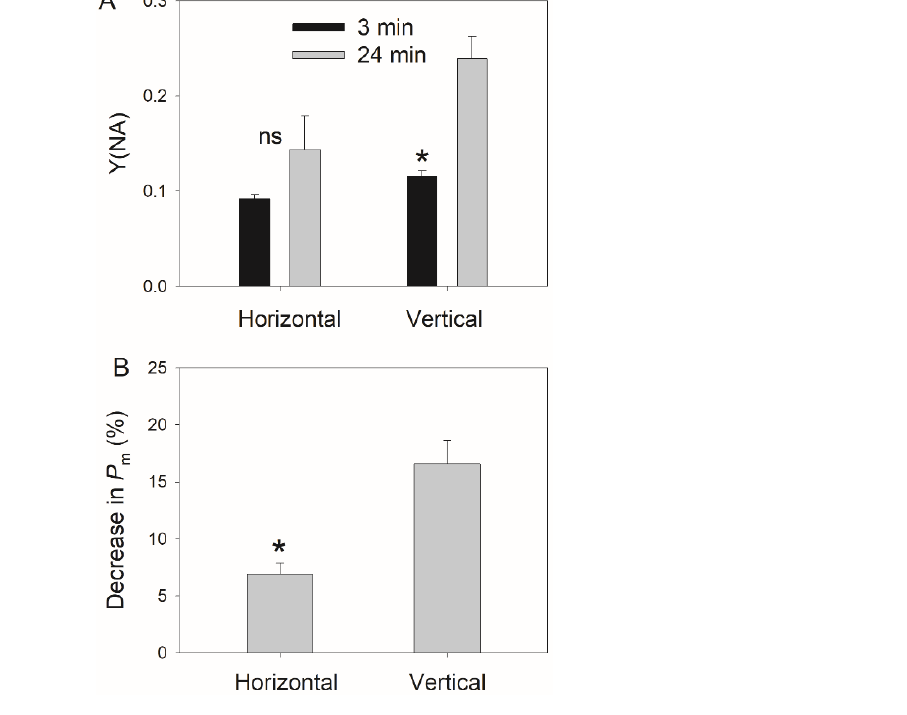
Figure 6. The effects of fluctuating light treatment on Y(NA) ( A ) and PSI activity ( B ) in the horizontal (leaf angle = 0°) and vertical (leaf angle = 60–65°) leaves. Asterisk indicates a significant difference between different treatments, and ns indicates no significant difference.